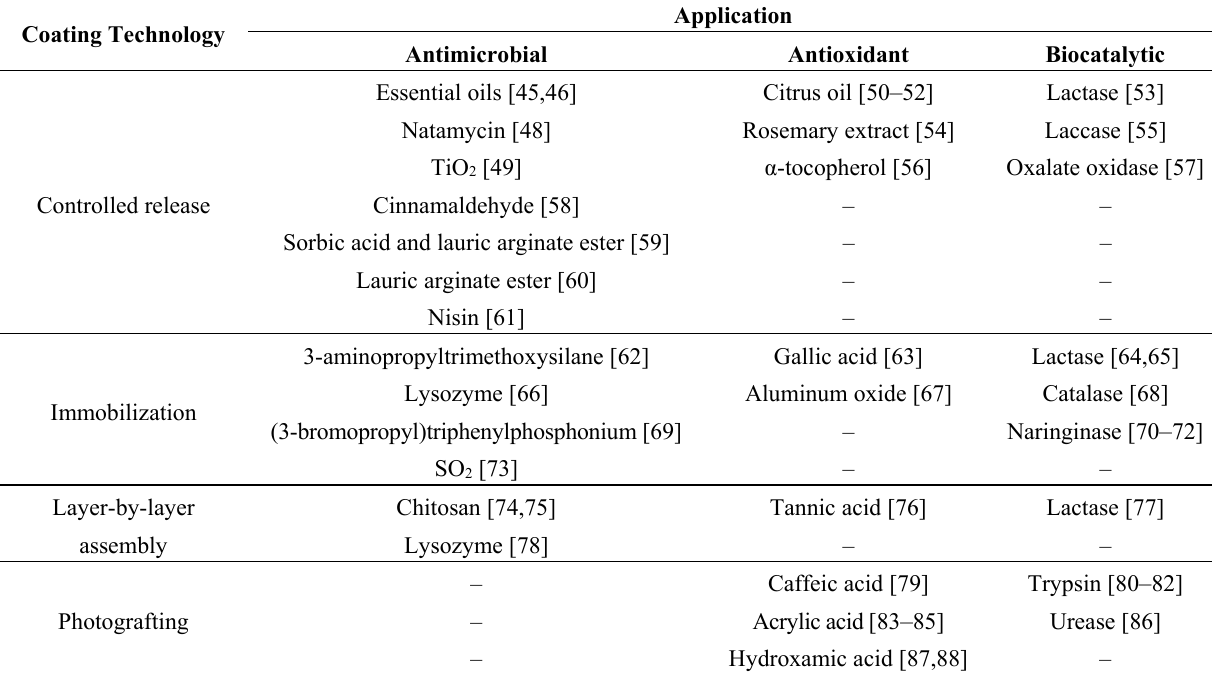
Table 1. Summary of technologies and applications in active packaging